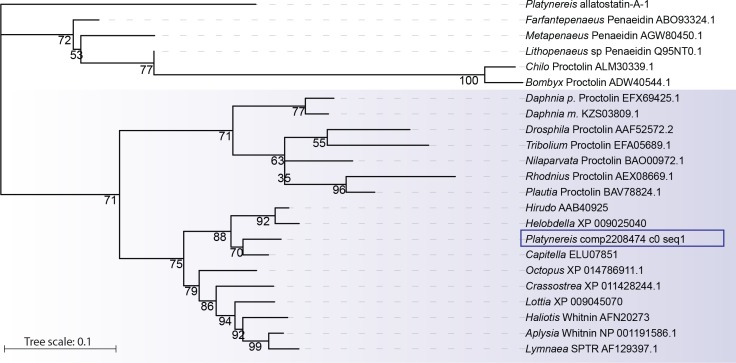
Platynereis Whitnin is part of a Proctolin/Whitnin family of neuropeptides.Maximum likelihood phylogeny of Proctolin/Whitnin family, see Figure 7—source datas 1 and 2 for alignment and Accession numbers.